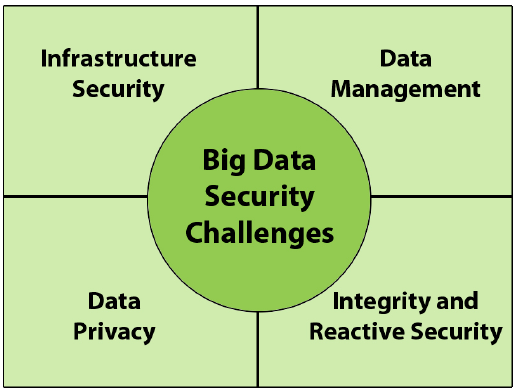
Figure 1. Main challenges as regards security in Big Data security, based on [9].